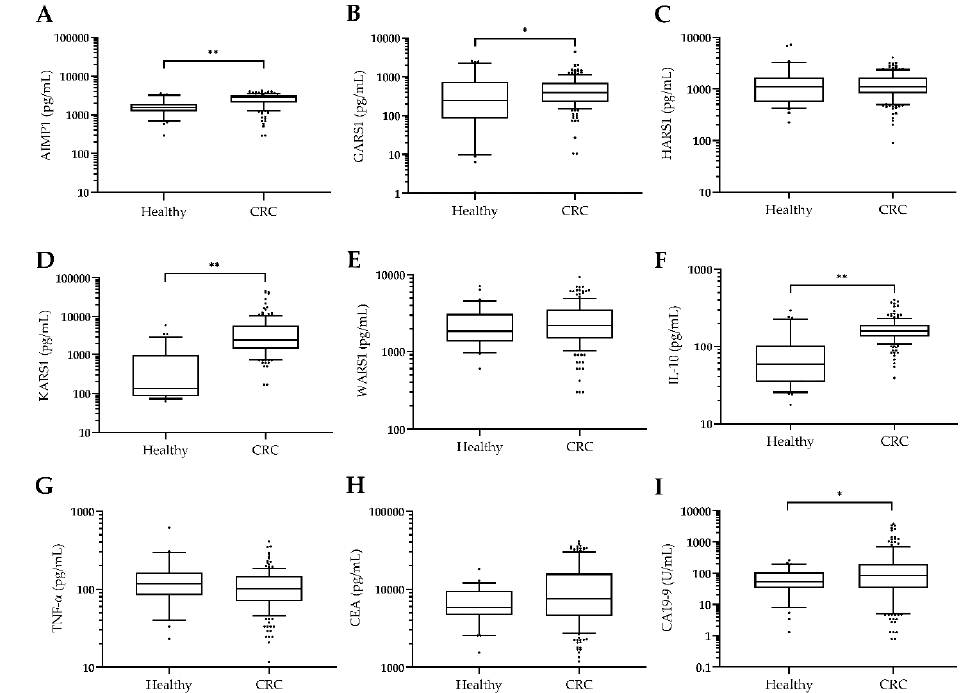
Figure 1. Levels of plasma biomarkers in colorectal cancer (CRC) patients and healthy controls. Levels: ( A ) Aminoacyl-tRNA synthetase-interacting multifunctional Protein 1 (AIMP1), ( B ) glycyl-tRNA synthetase 1 (GARS1), ( C ) histidyl-tRNA synthetase 1 (HARS1), ( D ) lysyl-tRNA synthetase 1 (KARS1), ( E ) tryptophanyl-tRNA synthetase 1 (WARS1), ( F ) interleukin 10 (IL-10), ( G ) tumor necrosis factor- α (TNF- α ), ( H ) carcinoembryonic antigen (CEA), and ( I ) carbohydrate antigen (CA) 19-9 in the plasma of healthy control ( n = 32) and CRC patients ( n = 164) were graphed as box and whisker plots. Except for CA 19-9 (U / mL), pg / mL was used as the unit. p -Values were calculated using the Mann–Whitney U test. * p < 0.05, ** p <